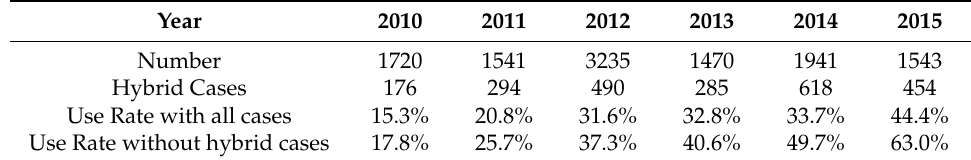
Table 1. Comparison of booster seat use rates in Winnipeg with and without hybrid